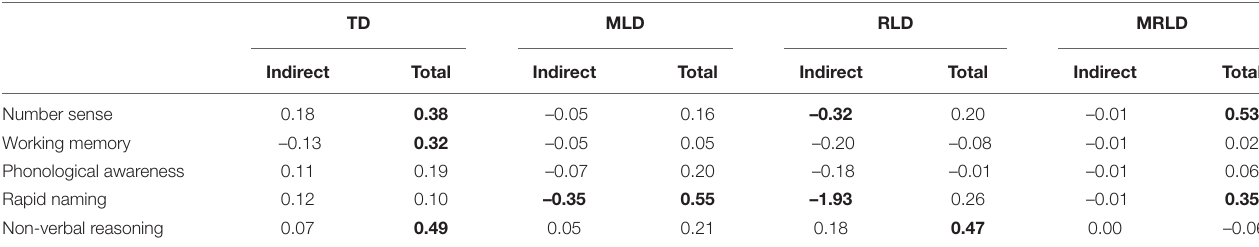
FIGURE 5 | Bayesian structural equation model for children with comorbid learning difficulties (MRLD). Denoted values are beta weights. TABLE 7 | Indirect and total effects (marked bold) for fact retrieval as mediator in the effects of the cognitive skills on